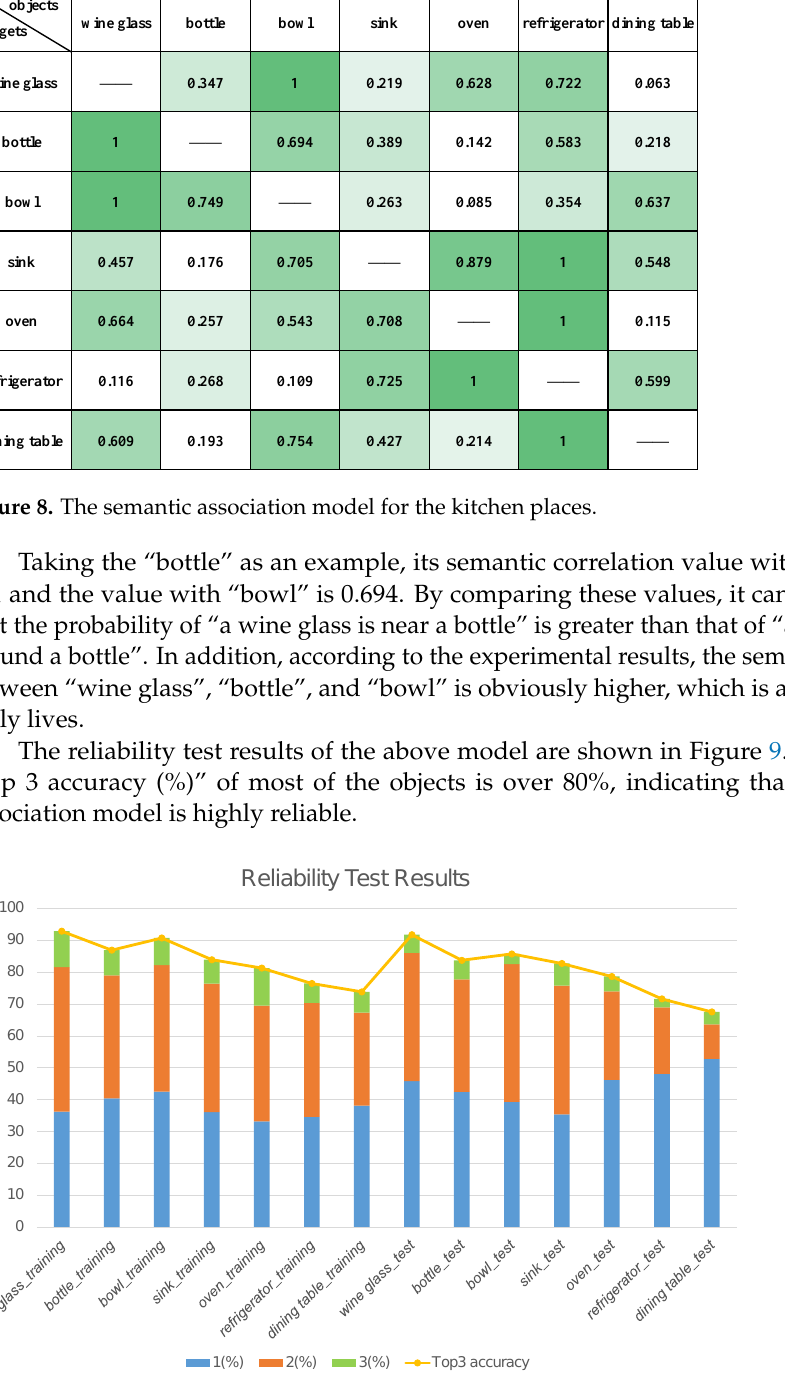
Figure 9. Reliability test results of the semantic association model for the kitchen places.